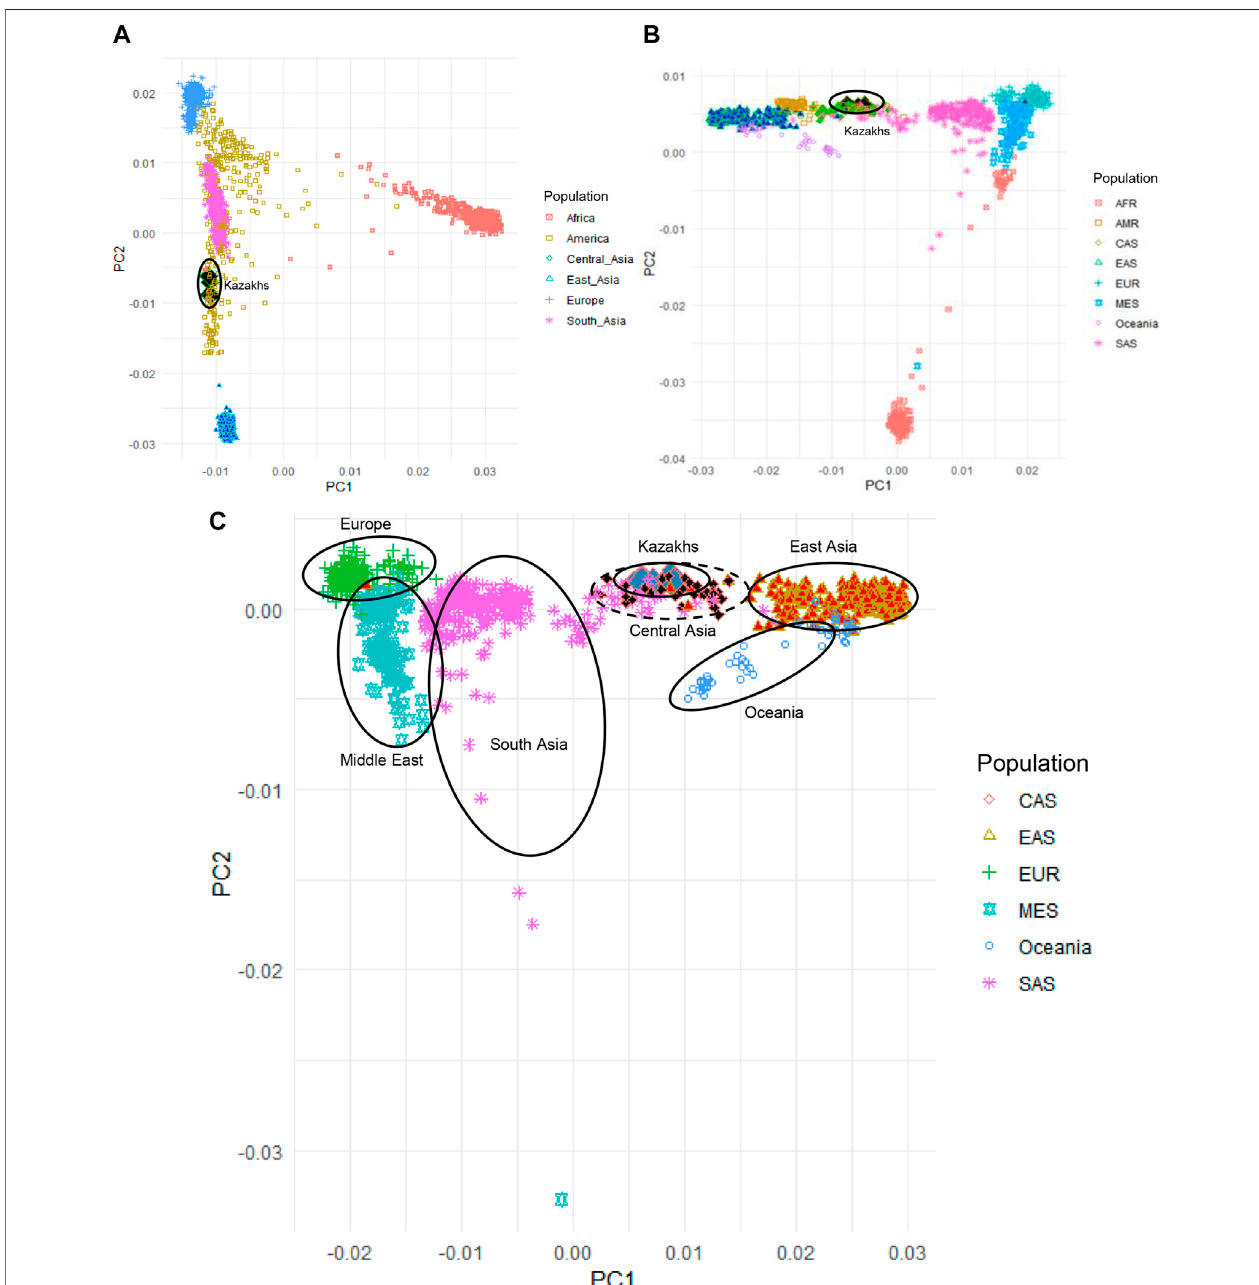
FIGURE 1 | Principal component analysis (PCA) of Kazakh samples along with samples from worldwide populations from 1000G, HGDP, and Jorde genomic projects. (A) PCA plot of Kazakh samples and 1000 G project; (B) PCA plot of Kazakh samples with the HGDP project; (C) PCA plot of Kazakh samples with Eurasian populations from the HGDP and Jorde genomic projects. Kazakh samples are highlighted in blue rhombus. AFR-Africa, AMR-America, CAS — Central Asia, EAS-East Asia, EUR-Europe, MES — Middle East, and SAS-South Asia.